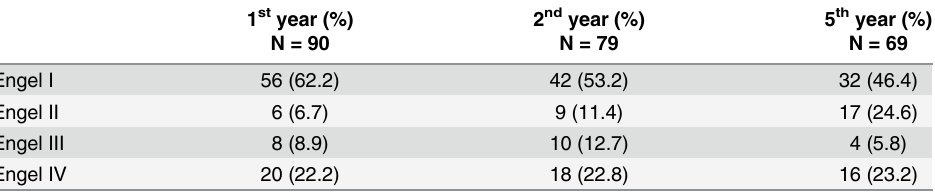
Table 3. Engel classification of postoperative